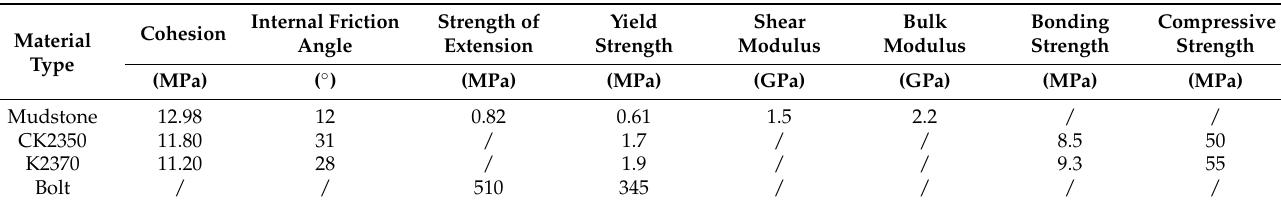
Table 2. Parameters of material